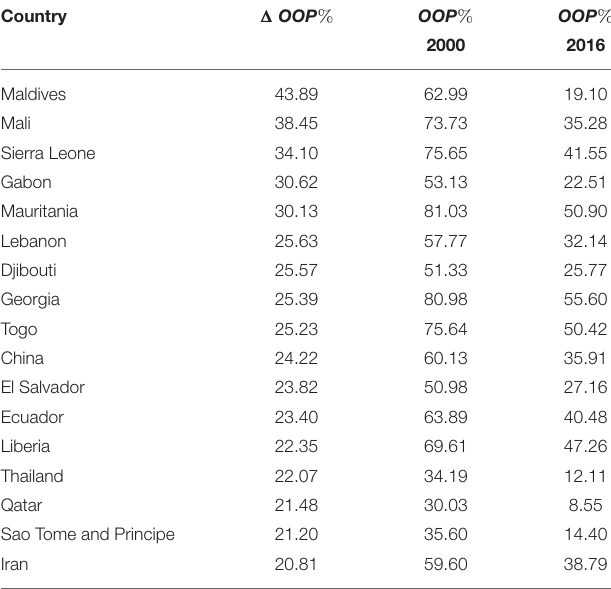
TABLE 1 | Regression results with THE .